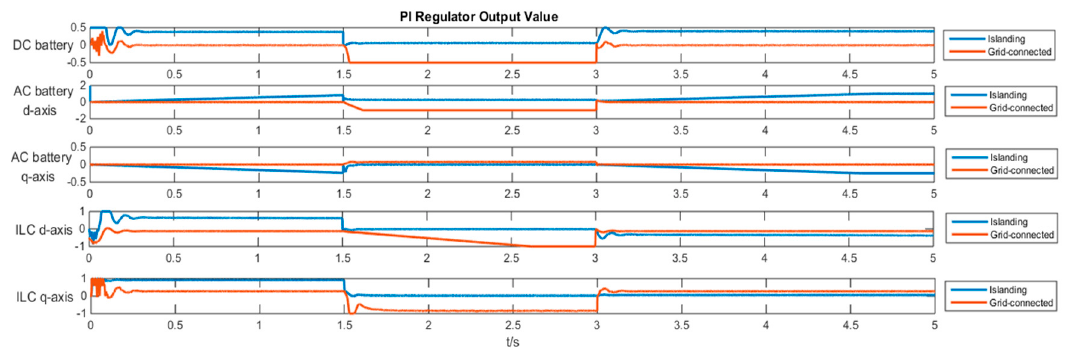
Figure 14. Regulation state of the traditional smooth transition control.